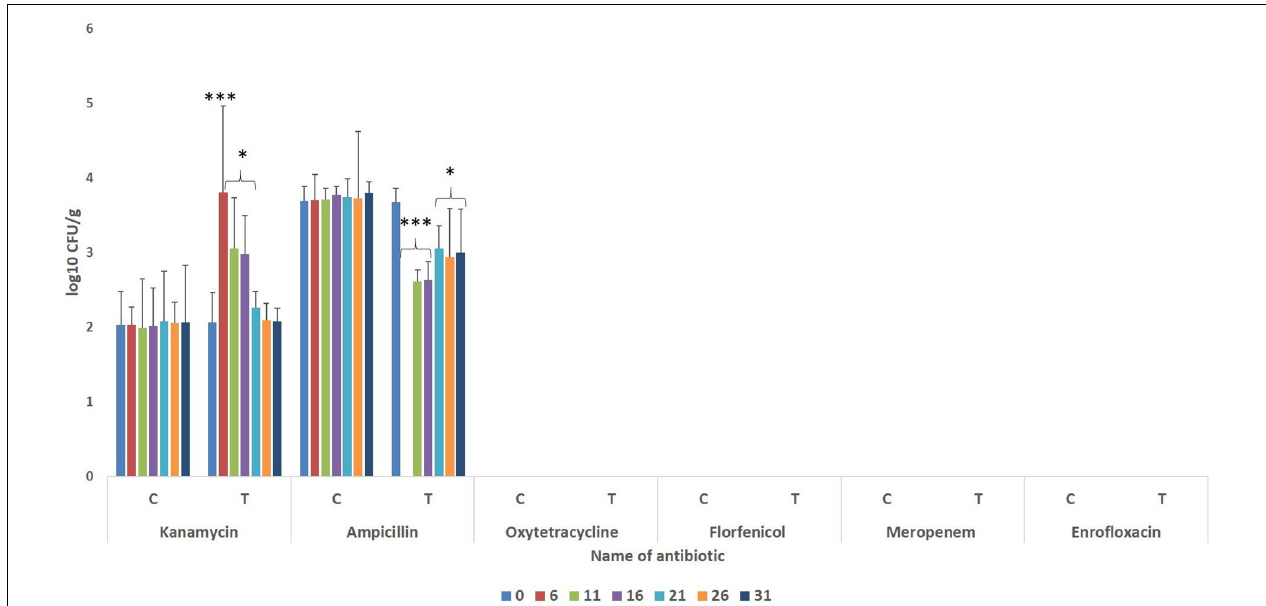
FIGURE 2 | Enumeration of antibiotic-resistant bacteria during different days of FFC exposure. Average log 10 CFU per gram of gut tissue ± SE is shown in Y-axis. P -values less than 0.05, 0.01, and 0.001 are summarized with one, two, and three asterisks, respectively, to represent the significant difference levels compared to the control animals. Different days after initiation of FFC treatment are shown in different color bars. CFU, colony-forming units; FFC, florfenicol; C, control fish; T, FFC treated